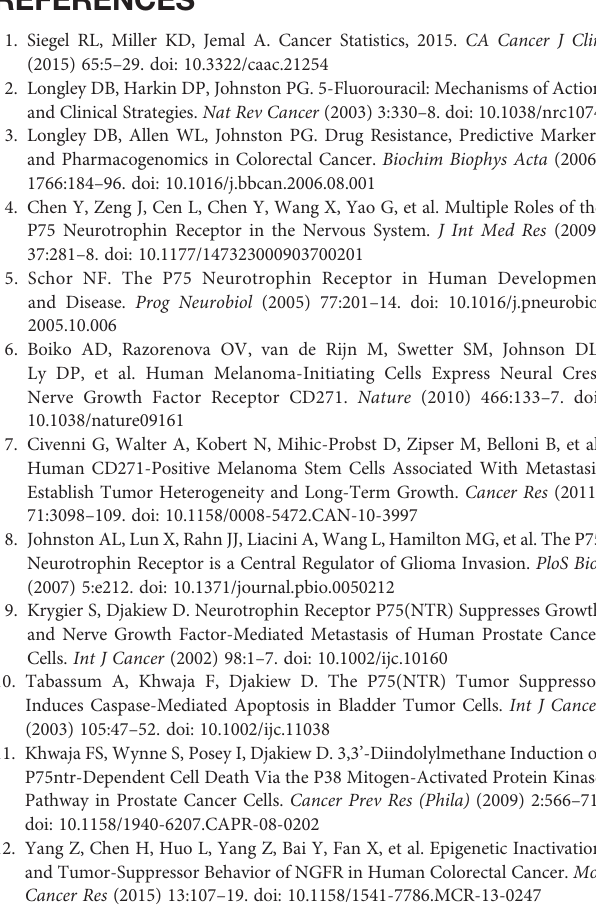
Supplementary Figure 1 | Histograms of the fold change between the experimental and control groups (NGFR vs. PURO). Fold change represents a logarithm of fl uorescence signal intensity ratios for differentially expressed genes. Log2 ratios of ≥ 1.0 and ≤− 1.0 indicate a twofold change. The histogram shows the